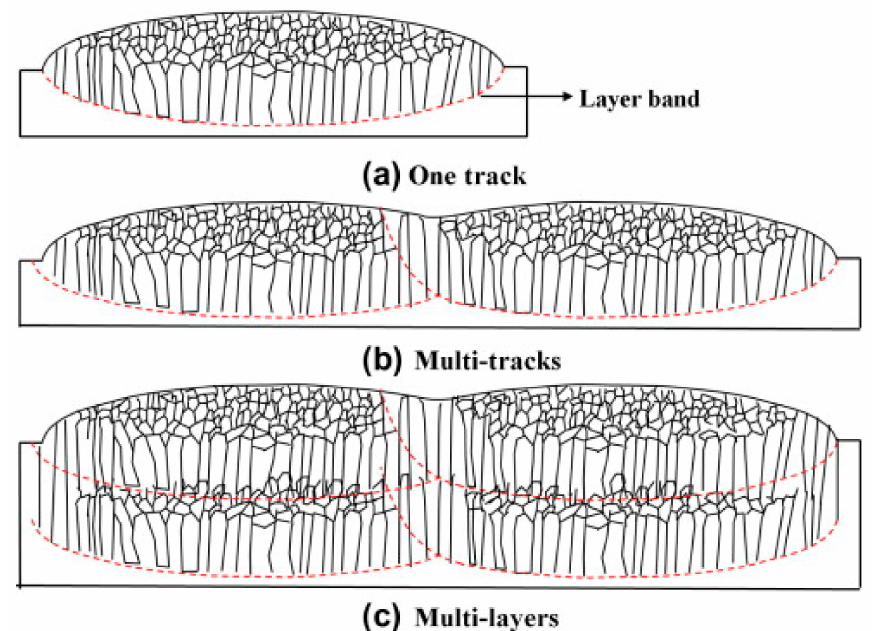
Figure 2. Schematic illustration of the formation process of β grains during the DED process, ( a ) one track, ( b ) multi-tracks, ( c ) multi-layers (reproduced with permission from [28] Copyright Elsevier, 2003).